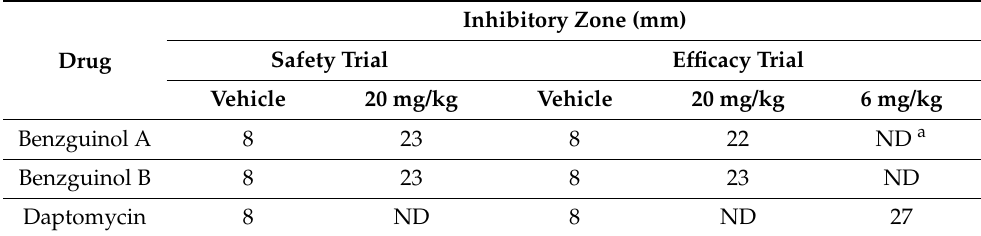
Table 3. Inhibitory zones of benzguinols A and benzguinol B formulations used for safety and efficacy trials.